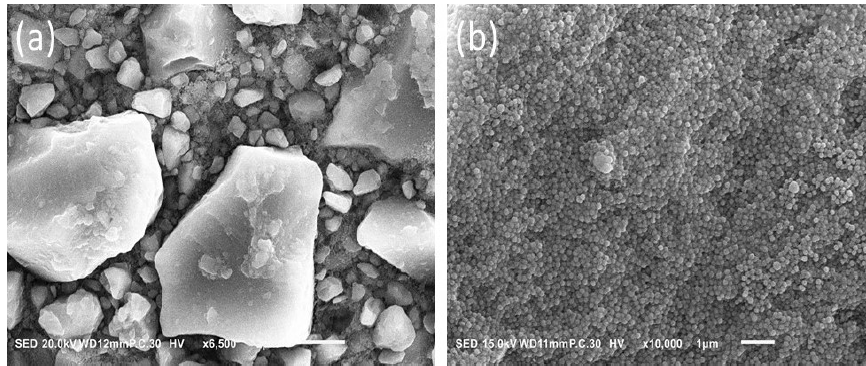
Figure 3. Difference in fillers’ shape and size between APX ( a ) and ESQ ( b ).